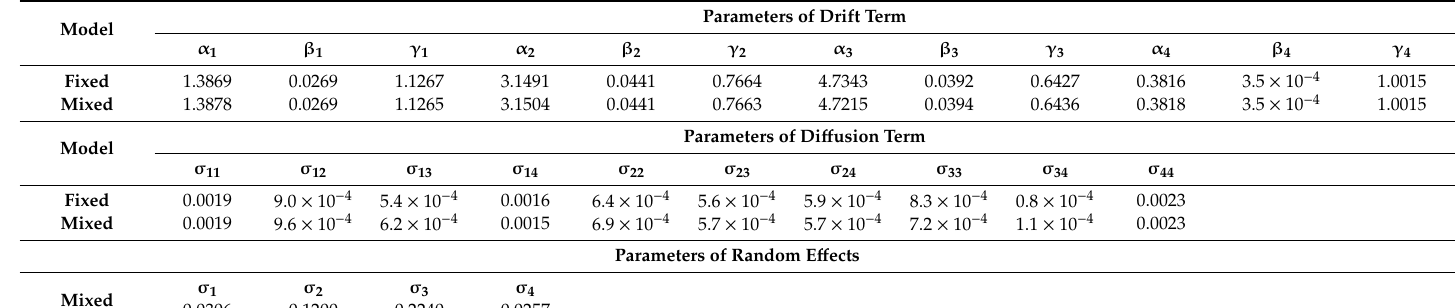
Table 1. Estimates of fixed e ff ect